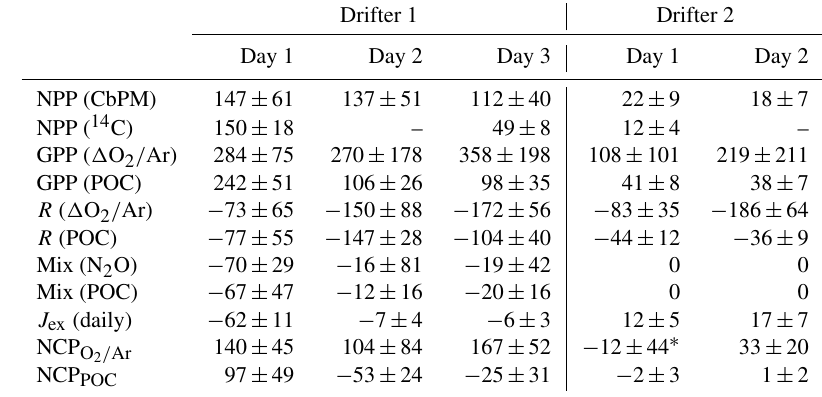
Table 1. Daily integrated mixed-layer net primary production (NPP) and net community production (NCP), including all components used to calculate NCP from (cid:49) O 2 / Ar or POC time series, as indicated: gross primary productivity (GPP), respiration (CR), vertical mixing (Mix), and gas exchange ( J ex ) . All units here are in millimoles of carbon per square meter per day (mmolCm − 2 d − 1 ). Note that CbPM is the carbon-based production model (Behrenfeld et al., 2005; Westberry et al., 2008; Graff et al., 2016) (Sect. 2.5).